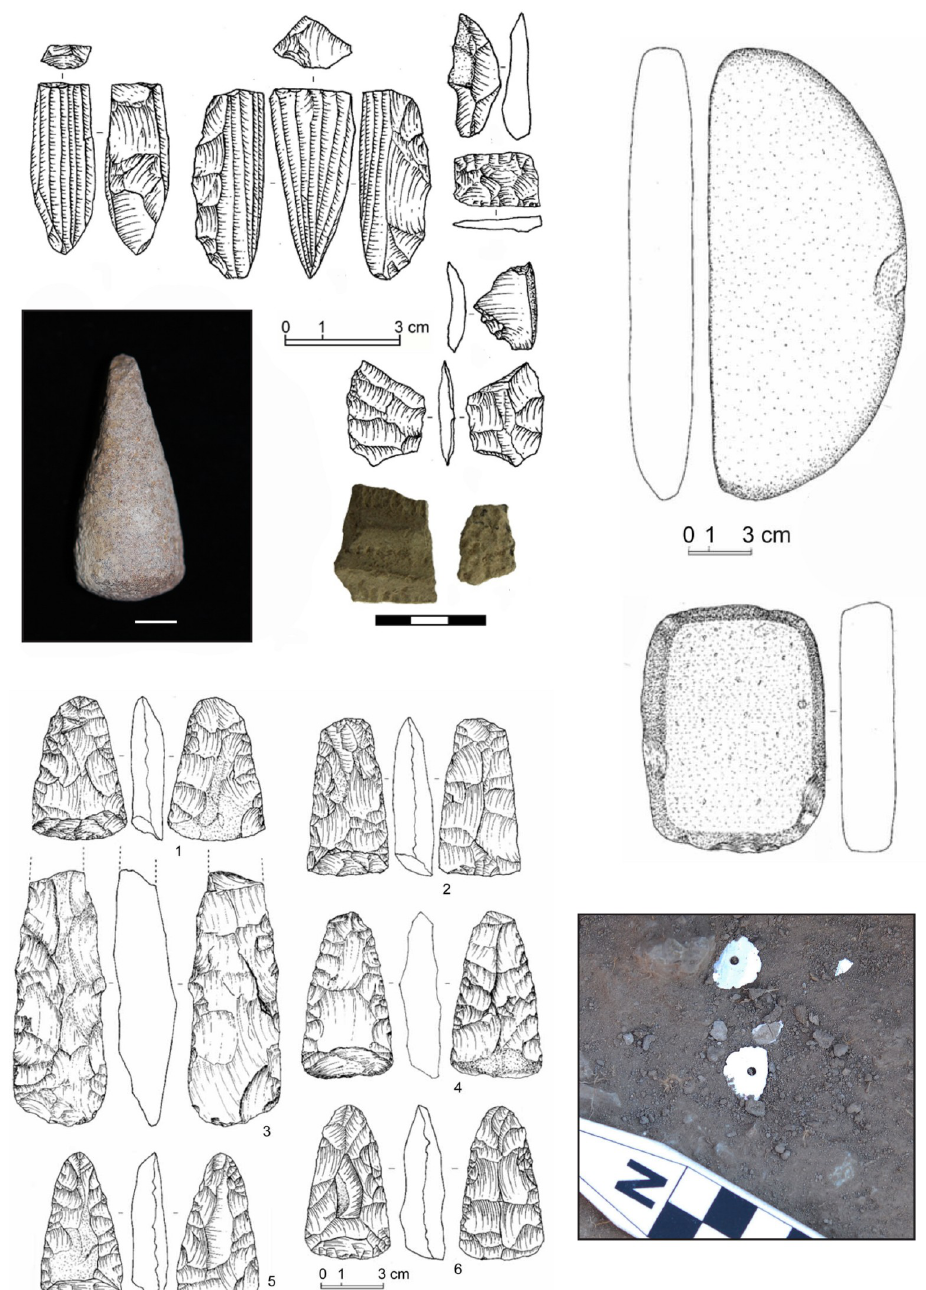
Fig 2. Examples of ground and flaked stone, pottery, and mother-of-pearl/nacre beads from Zaraa Uul.